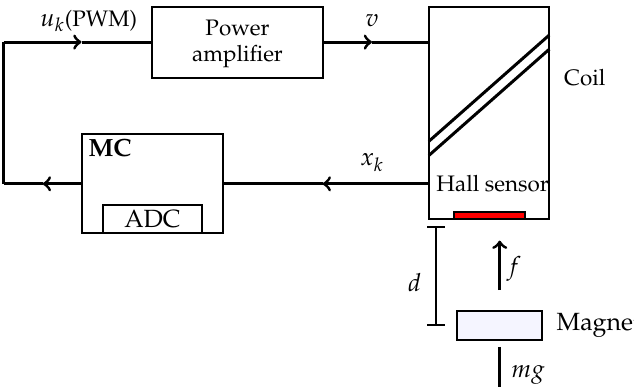
Figure 3. MagLev block diagram. The power amplifier receives the command u k and generates the corresponding voltage v supplied to the actuator (solenoid coil). The actuator then generates the electromagnetic force f . The levitated object, possibly a magnet with mass m , remains at a distance of d from the actuator’s bottom. The microcontroller (MC) reads the position x k , computes the control algorithm, and issues the control command u k in the format of a PWM signal.